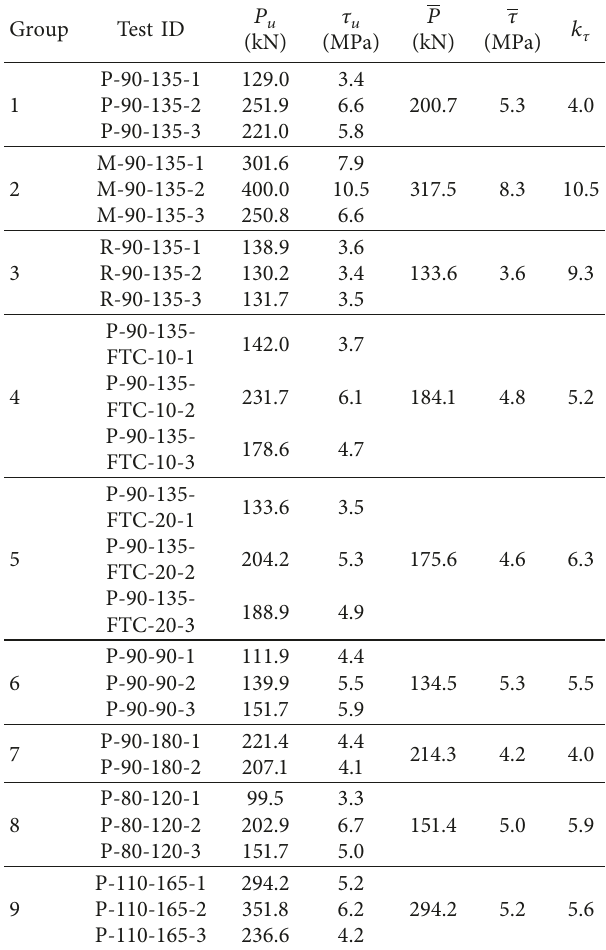
Figure 3: Test setup, (a) schematic diagram, (b) Real test setup. 1-Compression machine, 2-Specimen, 3-Displacement meter. Table 4: All specimens’ compression load, bond stress, and critical